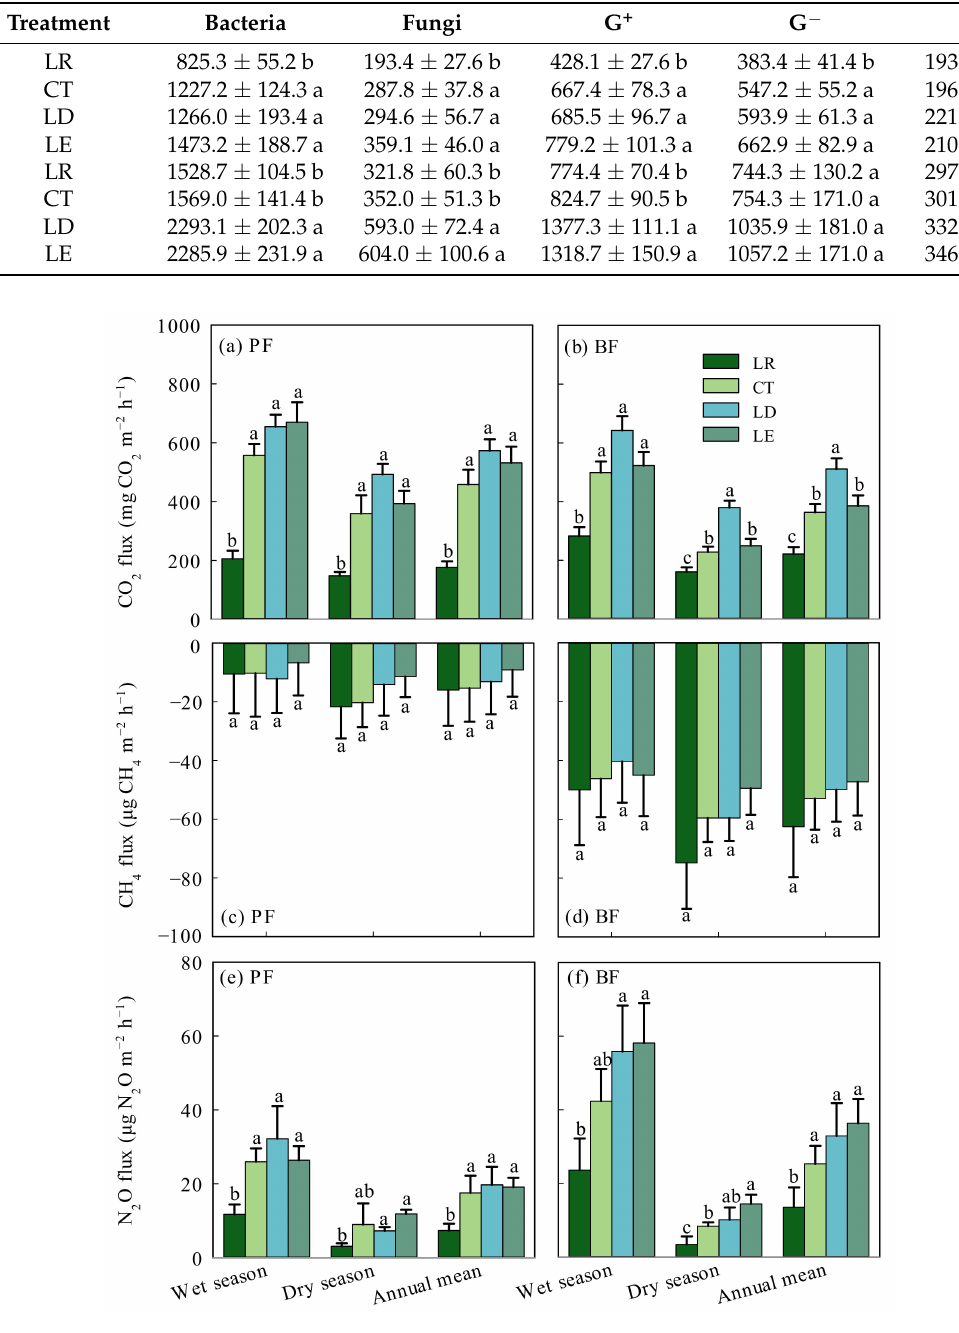
Figure 1. CO 2 , CH 4 , and N 2 O fluxes ( F CO2 , F CH4 , and F N2O ) in PF (Masson pine forest) and BF (evergreen broadleaved forest) in different experimental plots from August 2012 to July 2013. Error bar represents one standard error. Different lowercase letters indicates that there are significant differences at p < 0.05 between treatments. LR = litter removal; CT = control; LD = litter doubling; LE = litter